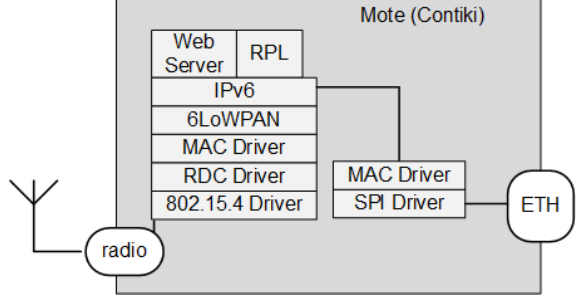
Figure 12. Complete 6LBR in a mote with Ethernet